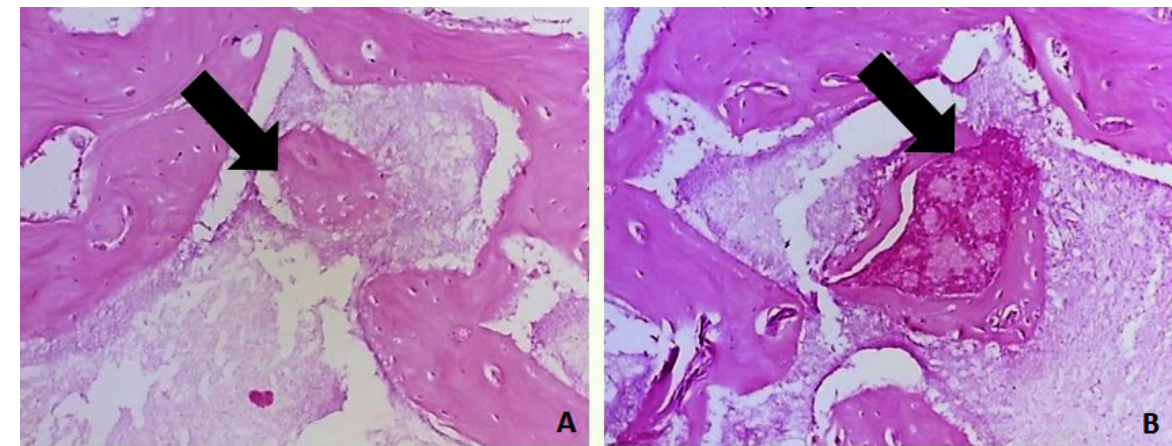
Figure 14. (A) and (B) Bone formation inside biphasic calcium phosphate granules at receptor site. Sections stained with hematoxylin and